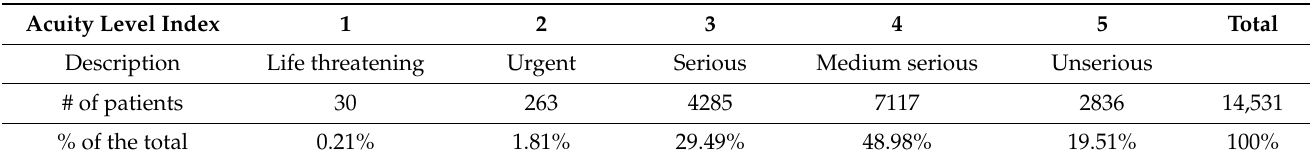
Table 4. Number of patients who came to PRPH’s emergency department with their acuity level index.